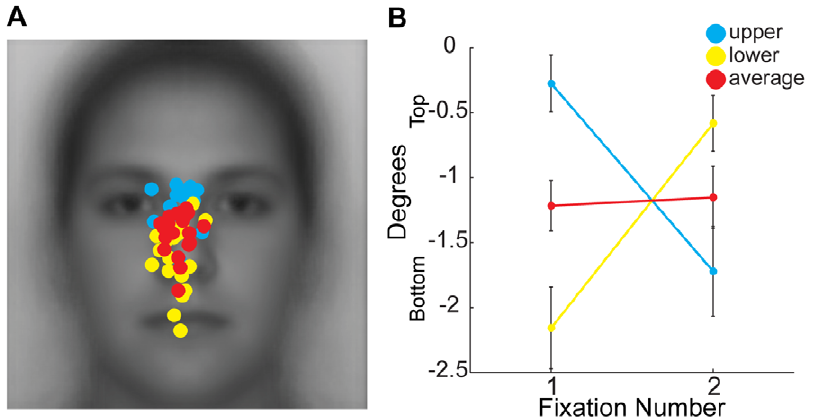
Figure 14. The problem of averaging across start positions. ( a ) First fixation locations across participants for the upper (blue) and lower (yellow) start positions for upright faces are replotted from Figure 6. The average location across these two start positions is plotted for each individual subject in red. Note that this averaging causes a regression to the center of face and obscures the tendency to fixate the side of face closest to the start location. Importantly, there is very little overlap in the distributions of fixation locations for the upper and lower start positions. ( b ) Average fixation locations, relative to the position of the eyes, in the vertical dimension for the upper and lower start positions for the first two fixations replotted from Figure 6. The average vertical location between these two start positions is plotted in red. Note that the average completely obscures the large shift in vertical bias between the first and second fixation. Error bars indicate the between-subjects error.